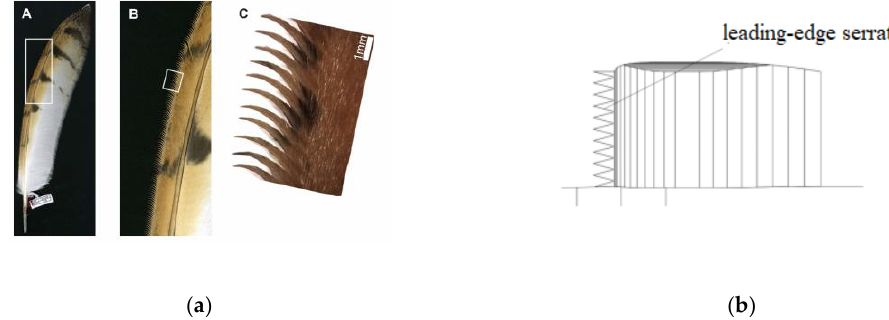
Figure 5. The structure of leading-edge serrations in owls and the sail hull. ( a ) Leading-edge serrations from owls. ( b ) Leading-edge serrations from the sail hull in our study.